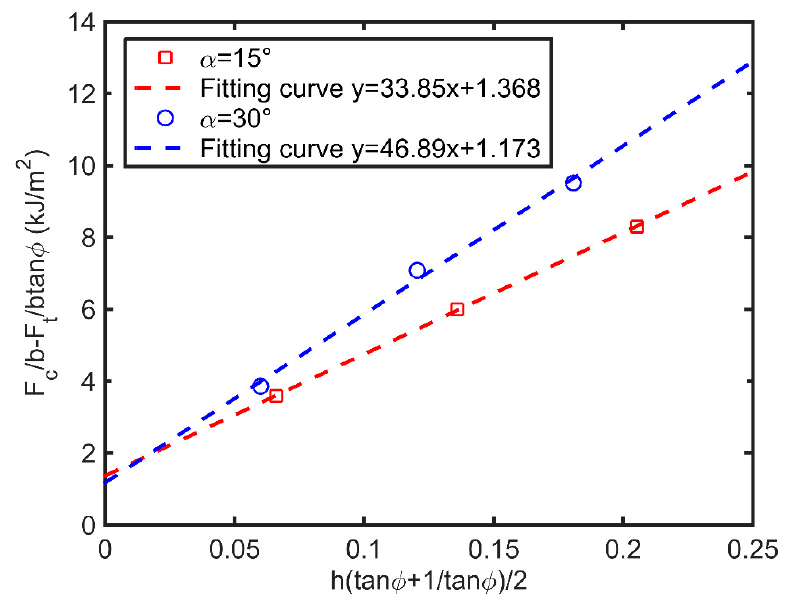
Figure 8. Fracture toughness obtained by orthogonal cutting.